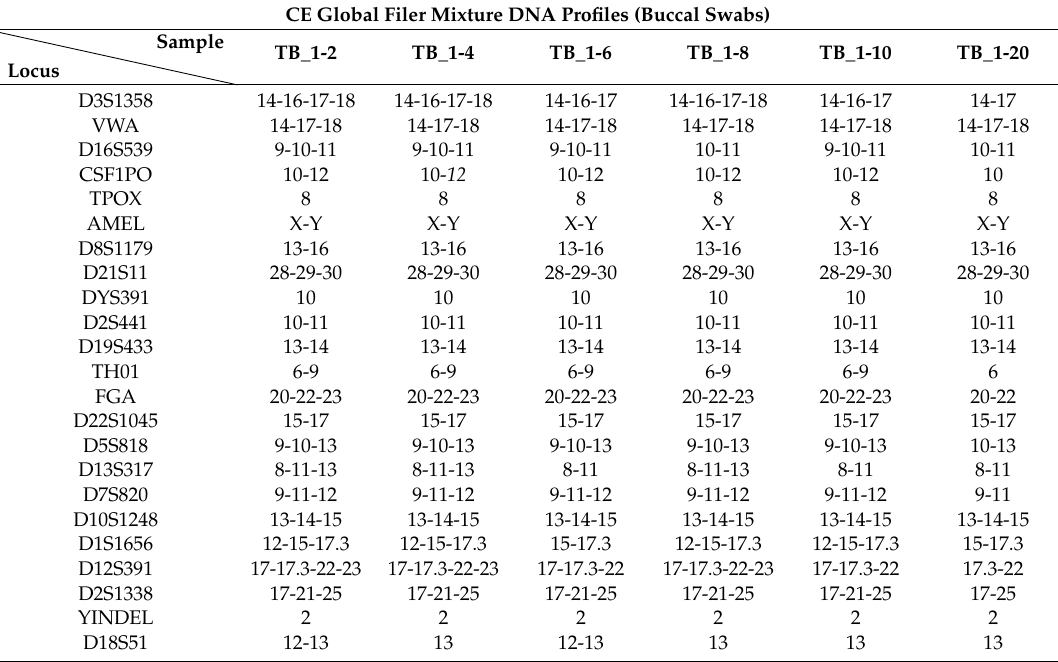
Table 2. Genotyping results for the buccal swab mixture samples. CE: Capillary Electrophoresis.